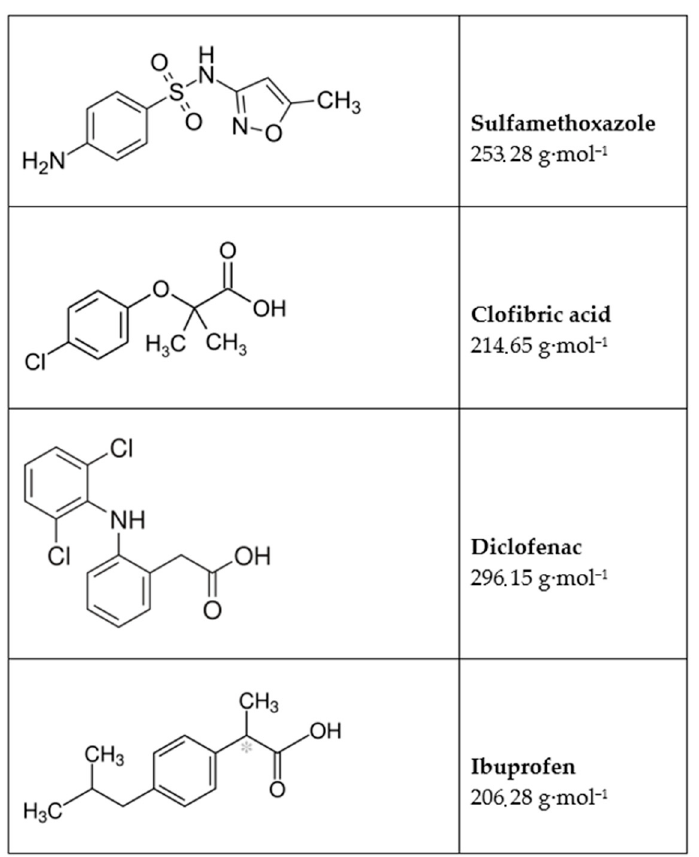
Figure 12. Structure and molecular weight of the tested micropollutants.